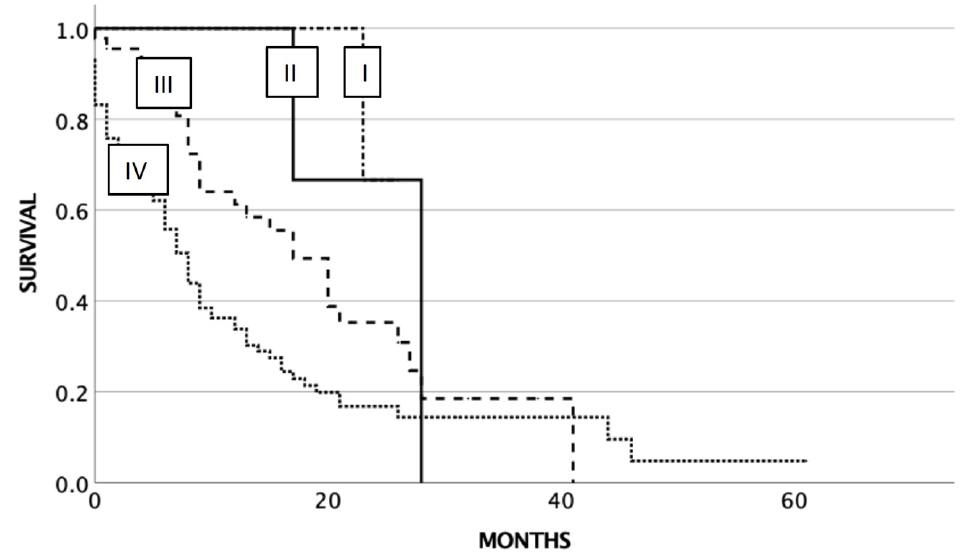
Figure 1. Overall survival related to UICC stage at diagnosis of SCLC.